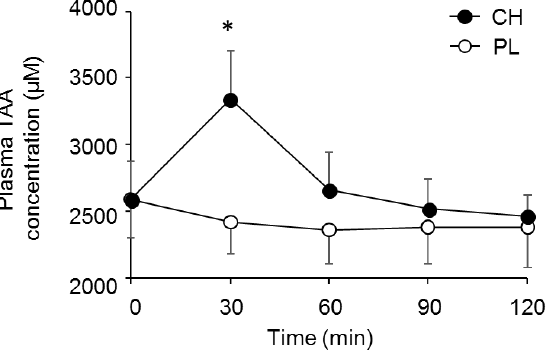
Figure 2. Plot showing the trend of plasma total amino acid (TAA) concentration as a function of time following casein hydrolysate (CH) or placebo (PL) ingestion ( n = 9) in the preliminary test. Values are expressed as mean ± SD. *, P < 0.001.